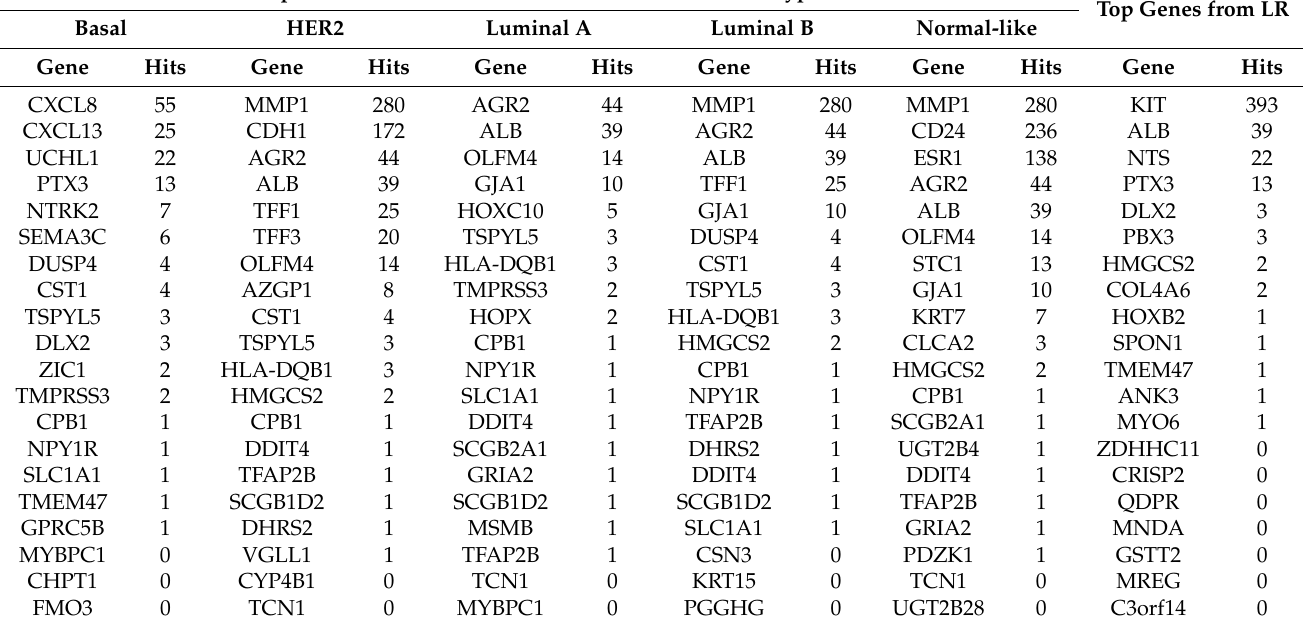
Table 2. Top 20 genes from each breast cancer subtype are given in the table for personalized classifier from LOOCV (PCC threshold = 0.2). The top 20 genes from Base LR are also given. Hits indicate that with that gene symbol, the number of PubMed hits occurred with the keyword metastasis/metastatic in the title/abstract of articles within the PubMed database. Genes are sorted by PubMed